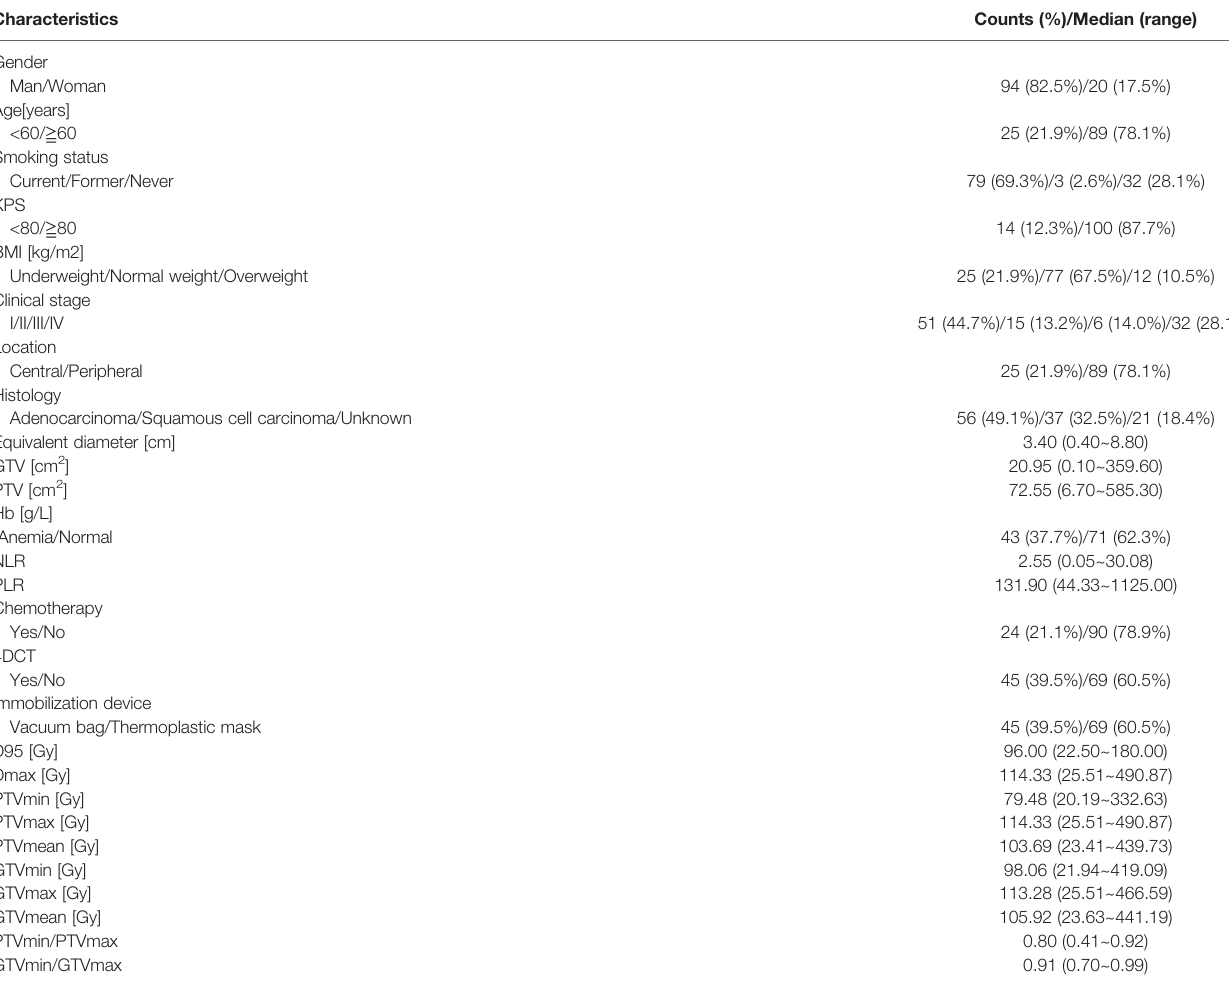
TABLE 1 | Lung cancer patients ’ clinical and dosimetric characteristics.